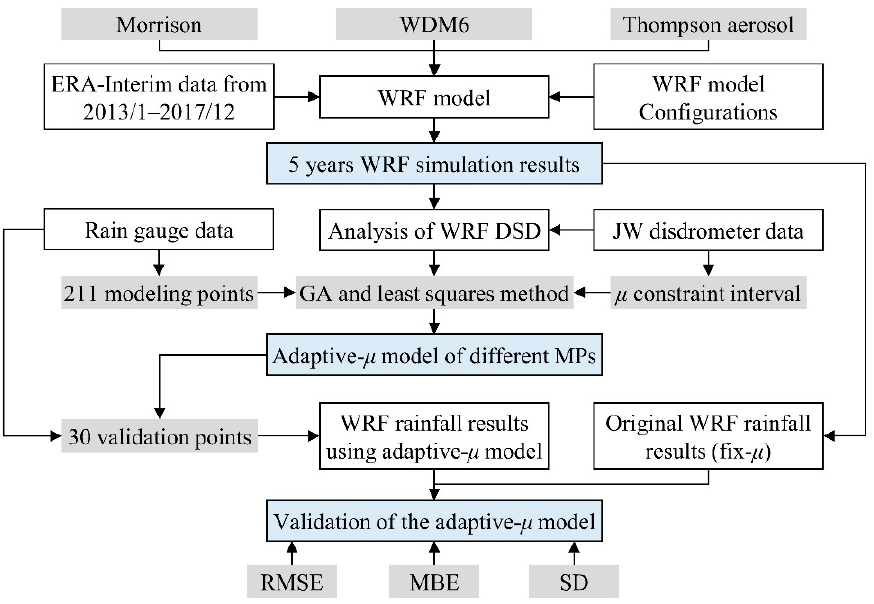
Figure 2. Schematic diagram of the experimental design.